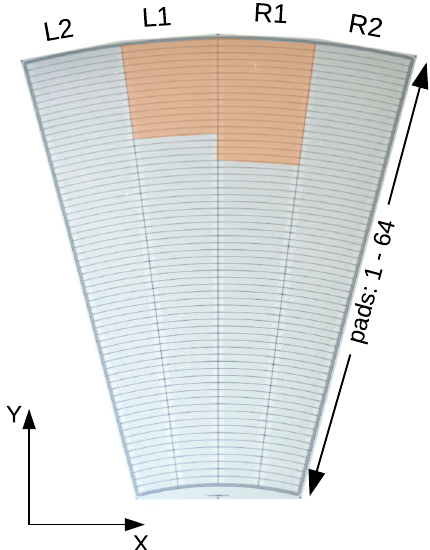
Fig. 5 A prototype silicon sensor for LumiCal. L1, L2, R1 and R2 are labels for the sectors. The shaded area denotes the pads that were connected to the electronics in this beam